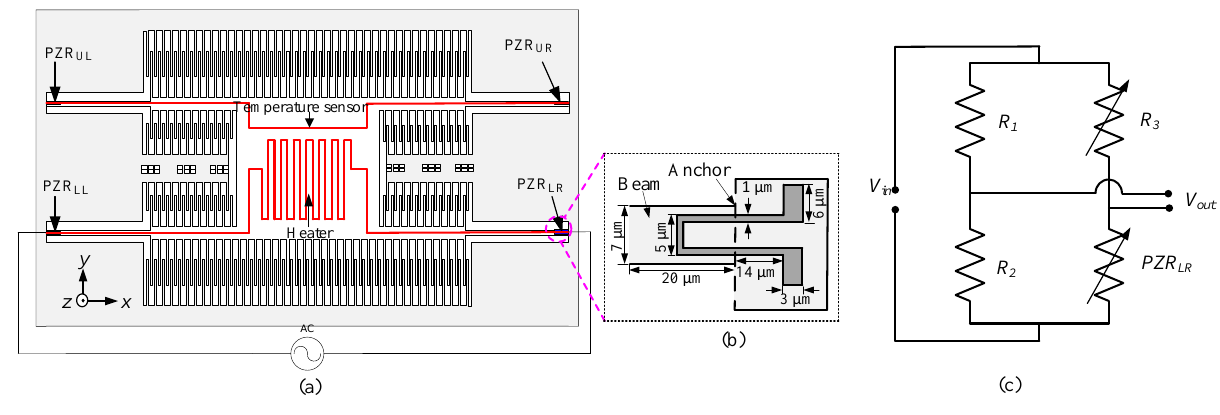
Figure 3. ( a ) Schematic of electrothermal actuation method and piezoresistive sensing; ( b ) A magnified view of PZR LR ; ( c ) Wheatstone bridge circuit for measurement of the output signal.